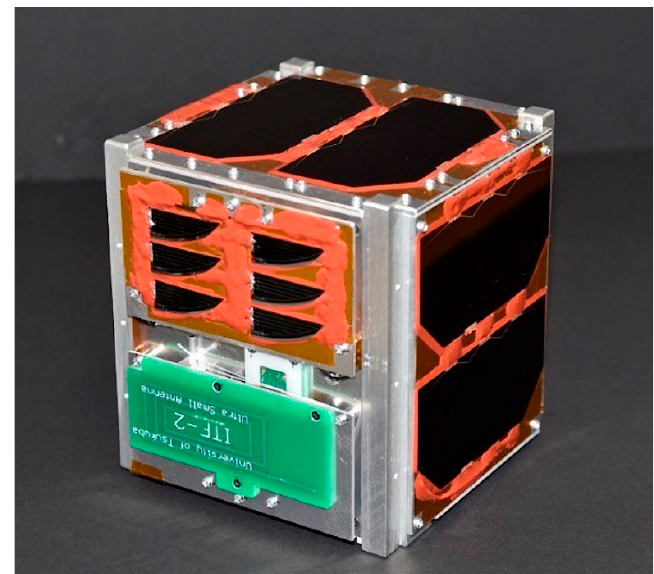
Figure 1. University of Tsukuba CubeSat ITF-2 (YUI-2).